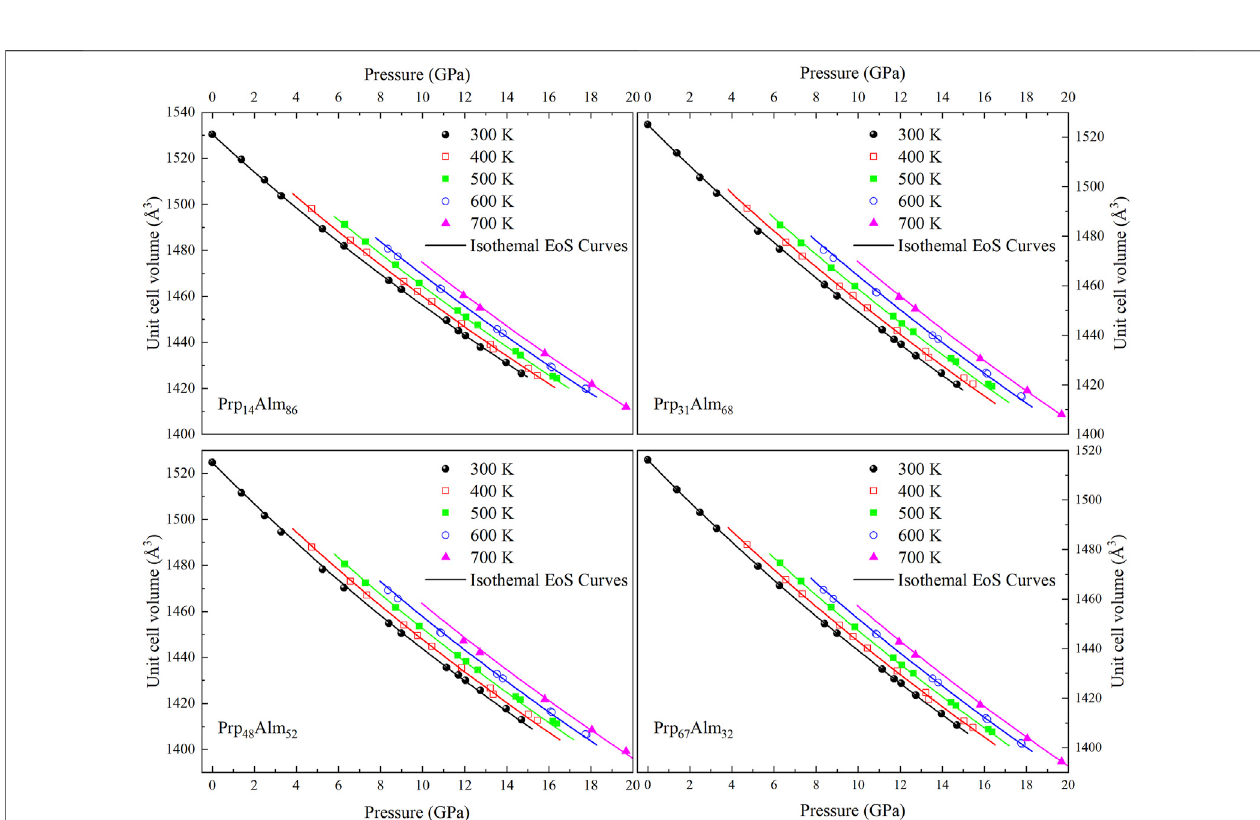
FIGURE 4 | The unit-cell volume of pyrope-almandine solid solution garnet as a function of pressure and temperature. The lines represent the isothermal compression curve from fi tting HTBM EoS at 300, 400, 500, 600, and 700 K. The error bars of the data points are smaller than the symbols.